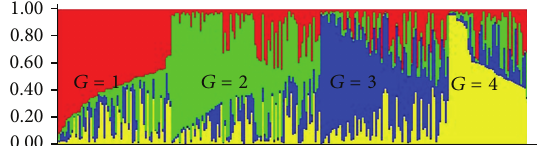
Figure 2: Estimated population structure of 250 FS progenies ( 𝑘 = 4 ). The 𝑦 -axis is the group (subpopulation) membership, and the 𝑥 - axis is the 250 individual FS genotypes. G (G1–G4) stands for